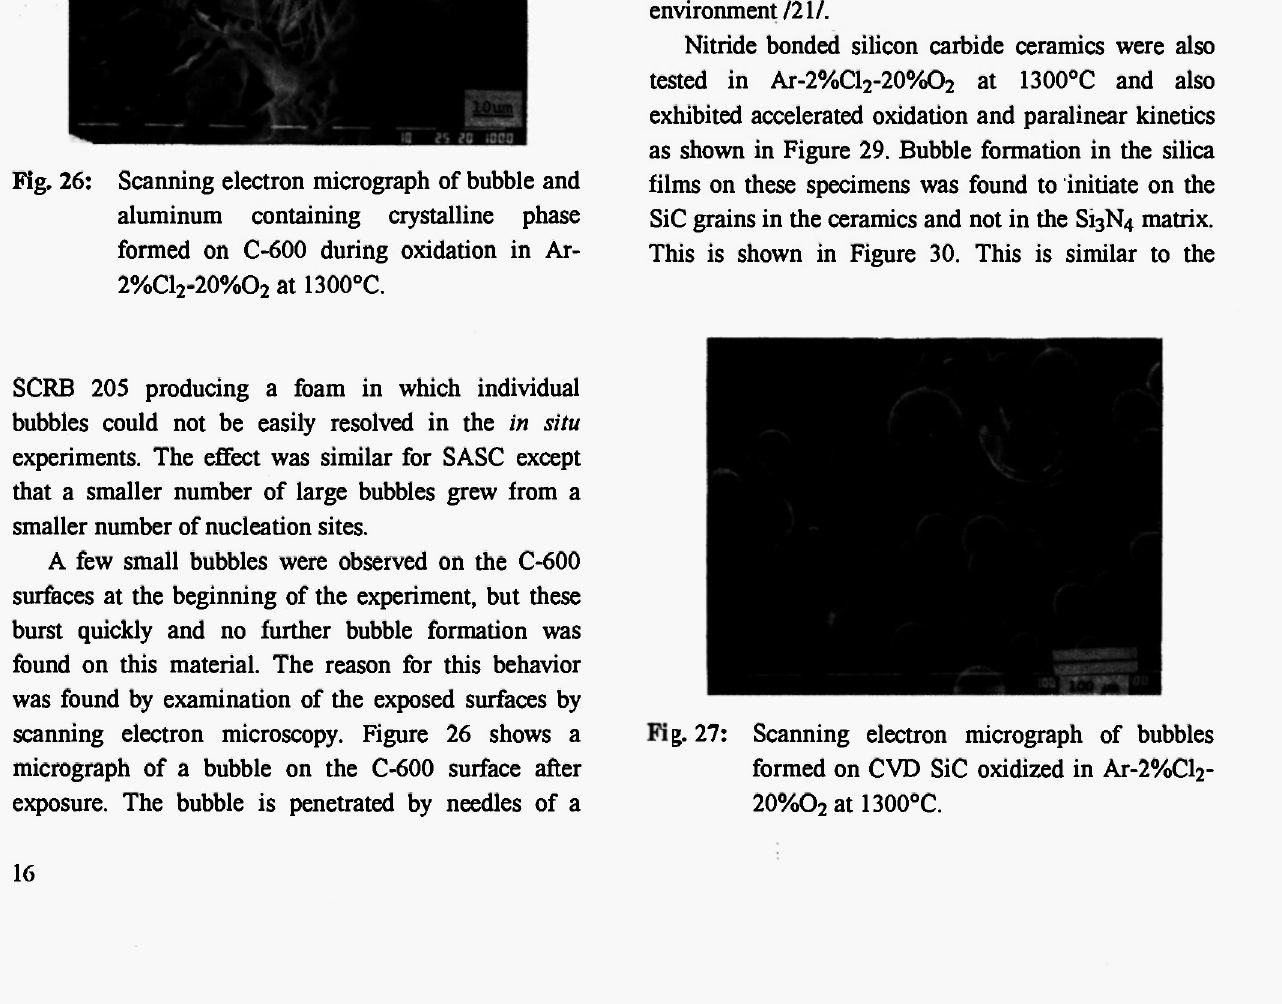
Fig. 25: Scanning electron micrograph of bubbles in Si0 film on SCRB 210 showing foam of 2 fine bubbles nucleated at Si/SiC interfaces.